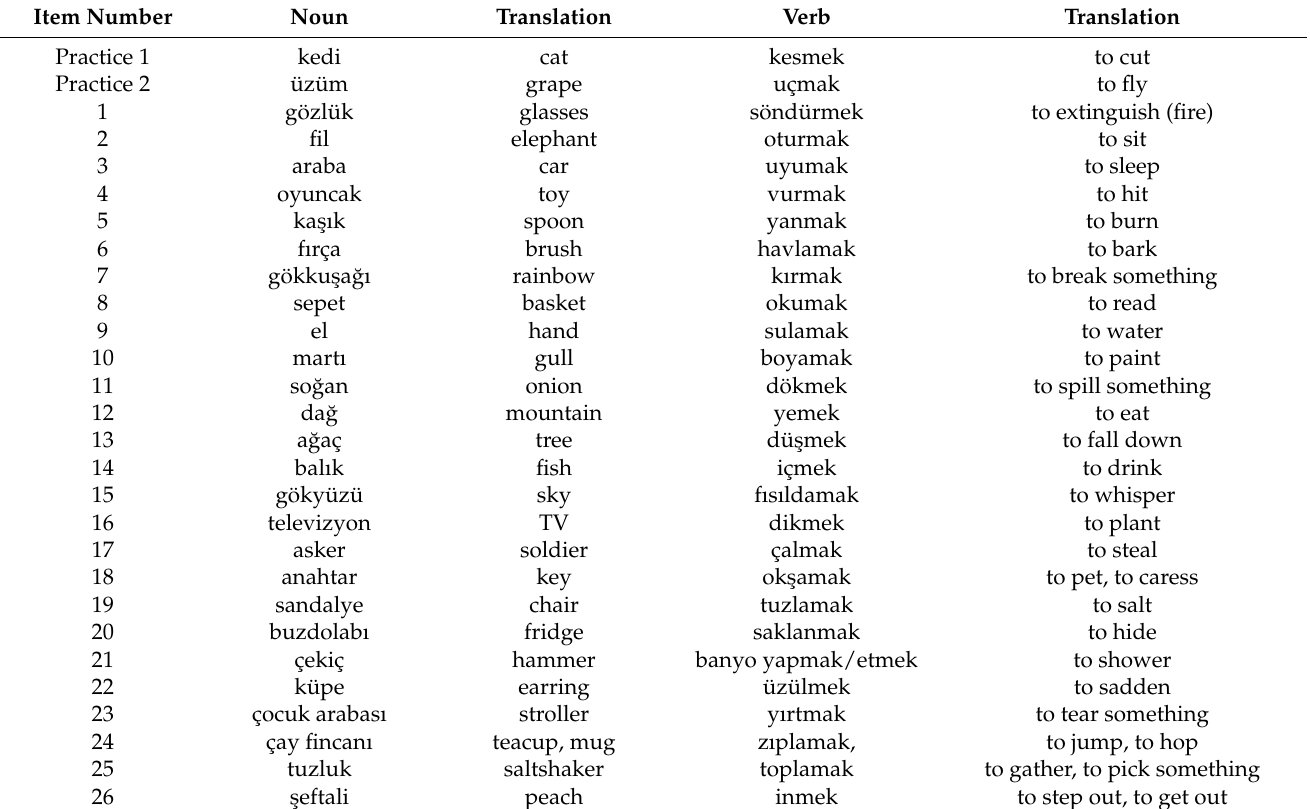
Table A1. Items of the subtest “Expressive Lexicon” of the Turkish language proficiency